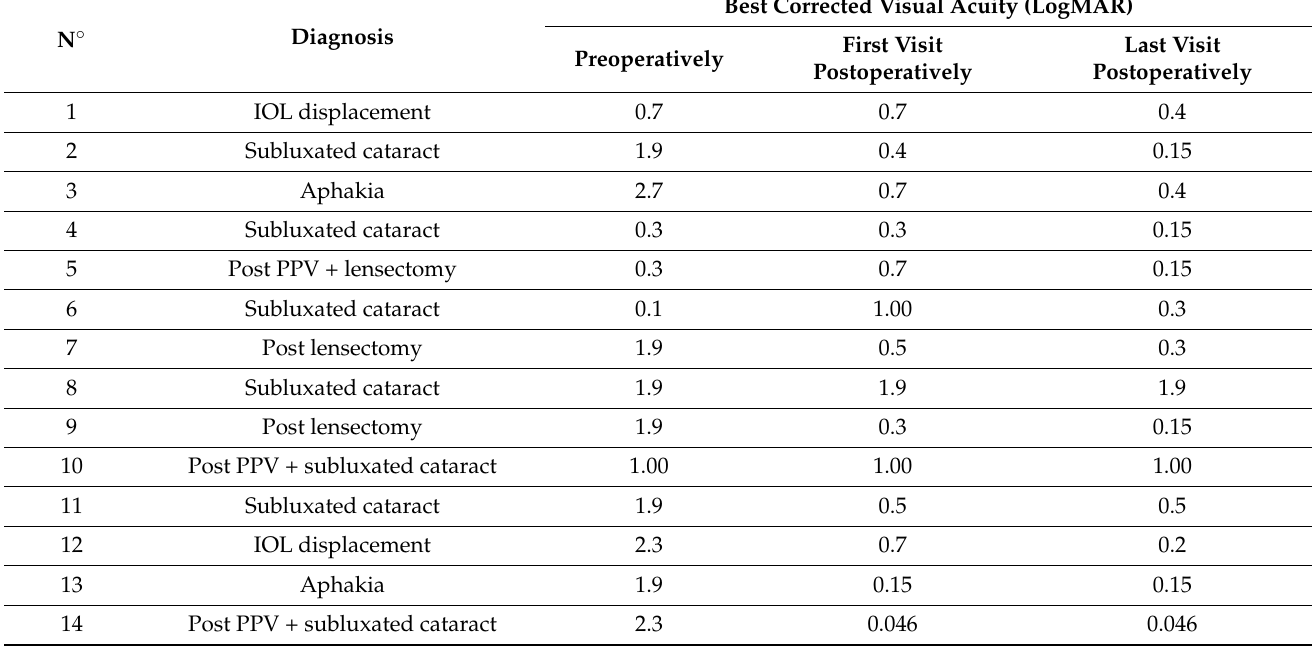
Table 1. Preoperative and postoperative visual outcomes in eyes with posttraumatic aphakia treated with the Yamane technique followed by anterior vitrectomy (Group